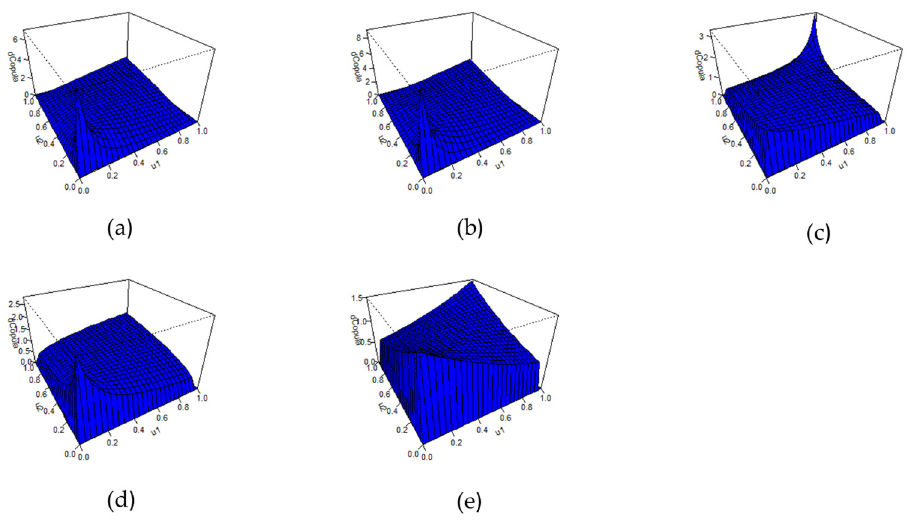
Figure 15. The plot of joint density function cluster type I